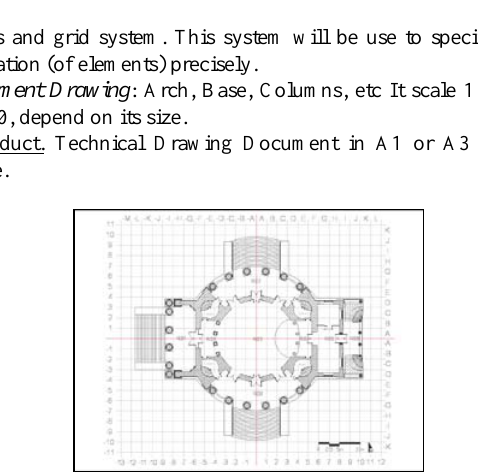
Figure 3. Sample of technical drawing plan, with grid and axis